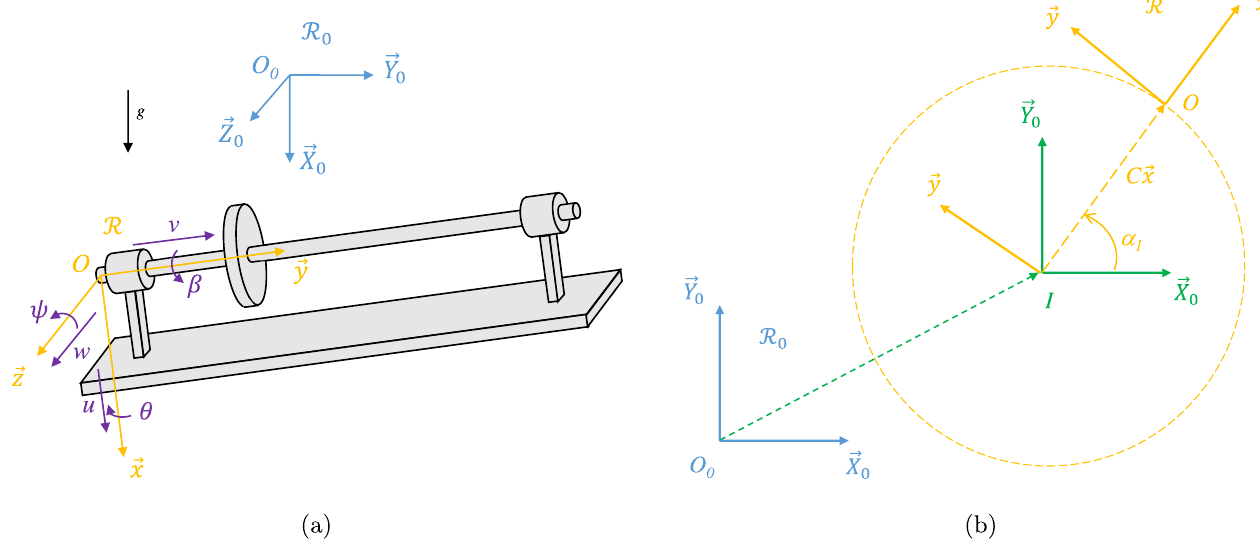
Fig. 1. (a) Sketch of an on-board rotor and (b) Example of an in-plane motion of the moving frame R , composed of two translations along (cid:126)X 0 and (cid:126)Y 0 and a rotation of angle α 1 and radius C